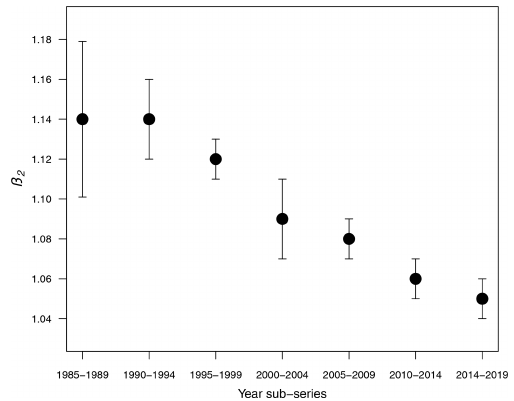
Figure 3. Decay of β 2 over the years. Vertical bars represent 95% confidence intervals estimated from